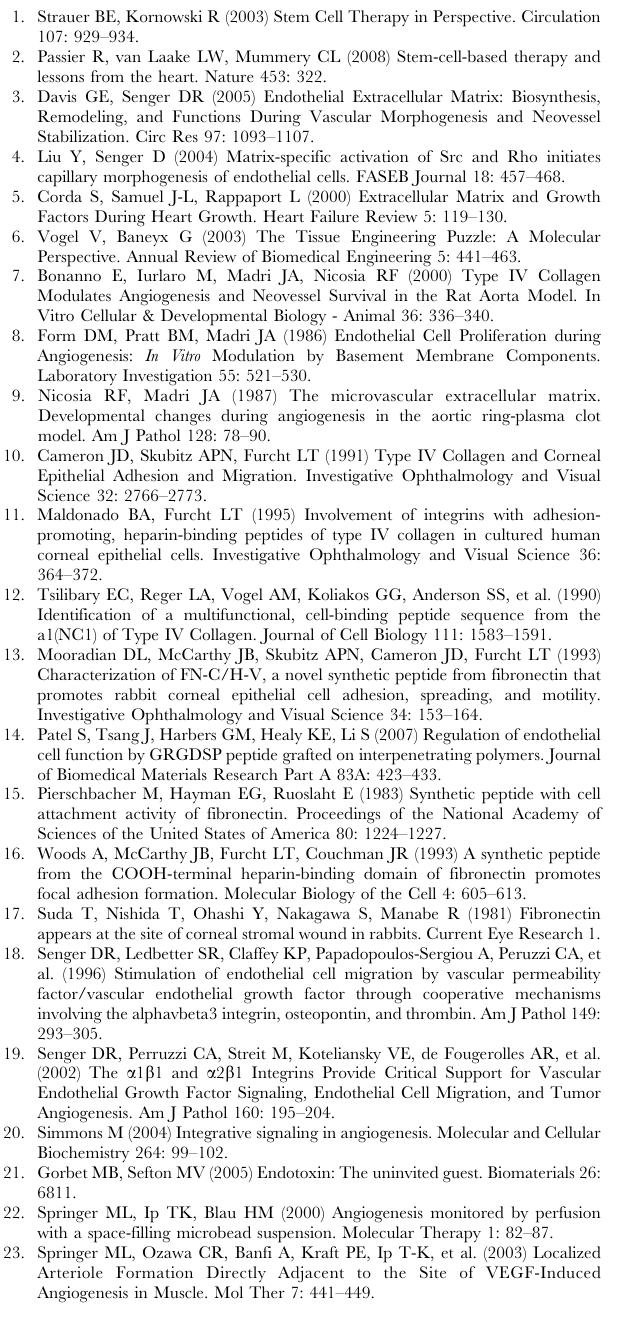
Figure S2 Found at: doi:10.1371/journal.pone.0010384.s002 (0.10 MB Figure S3 Found at: doi:10.1371/journal.pone.0010384.s003 (0.11 MB Figure S4 Found at: doi:10.1371/journal.pone.0010384.s004 (0.09